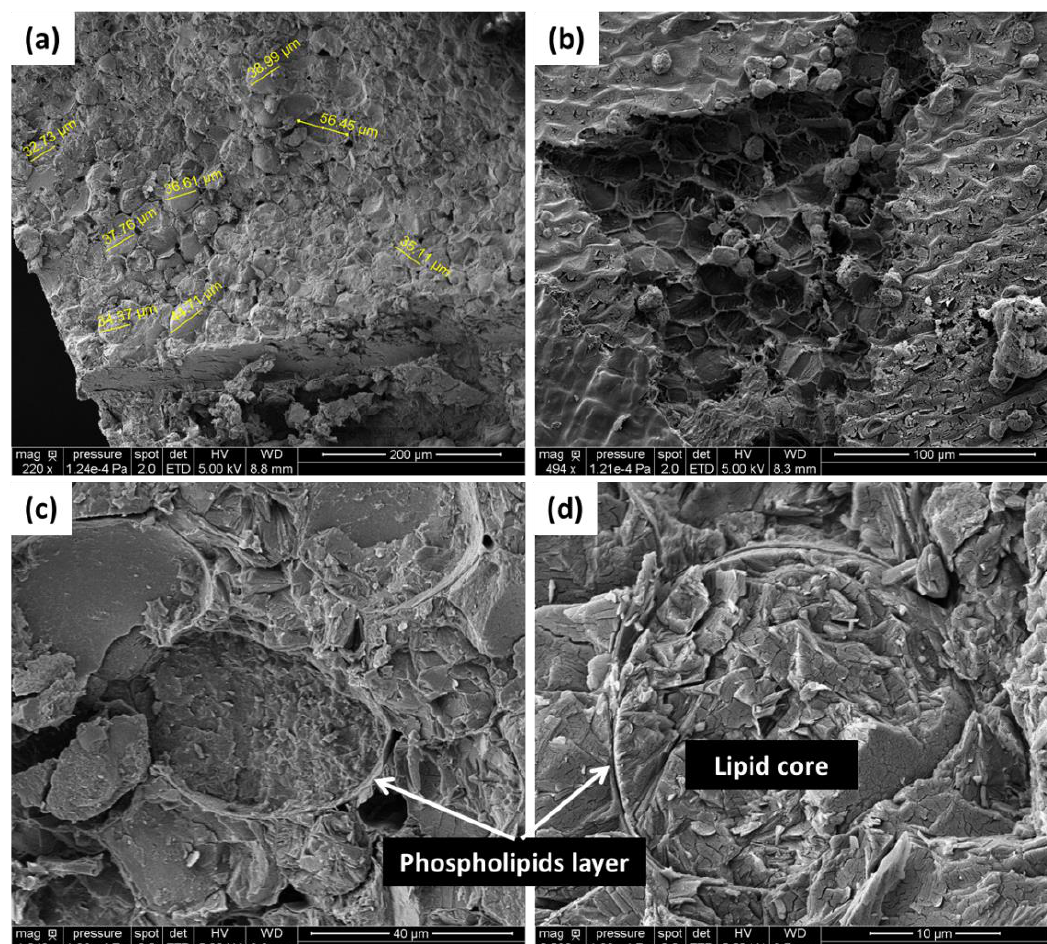
Figure 2. Ultrastructure of the almonds of I. gabonensis seen in electronic microscopy at a pression of 1.33 × 10 -4 to 1.21 × 10 -4 Pa. ( a , b ): Fracture of the almond showing the oleosomes of different sizes. ( c , d ): Enlargement of the oleosomes showing the lipid core and the